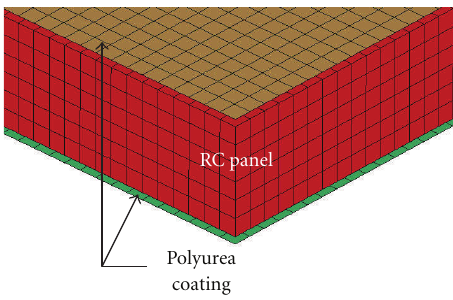
Figure 2: A section of panel